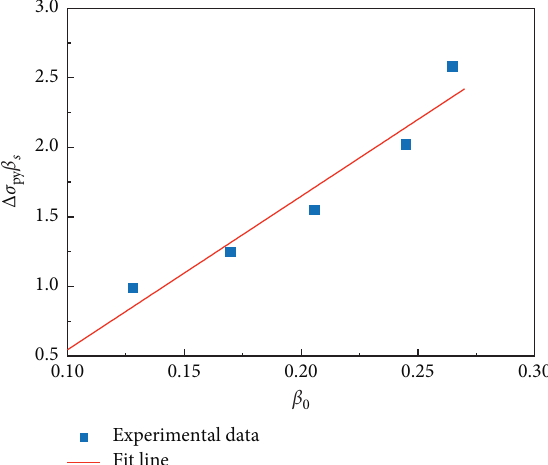
Figure 10: The relationship between Δ σ Table 7: The calculation error of Δ σ